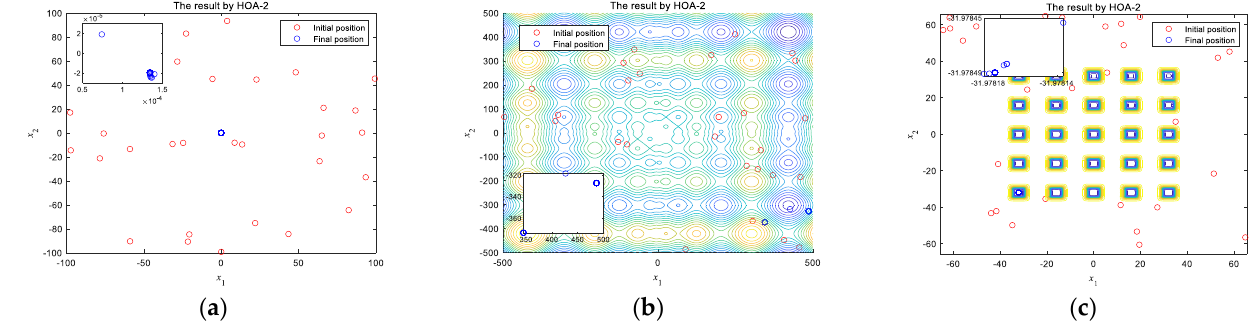
Figure 7. Initial and final positions of B-particles solved by HOA-2 for ( a ) F1; ( b ) F8; ( c ) F14. Table 2. Results of unimodal benchmark functions.